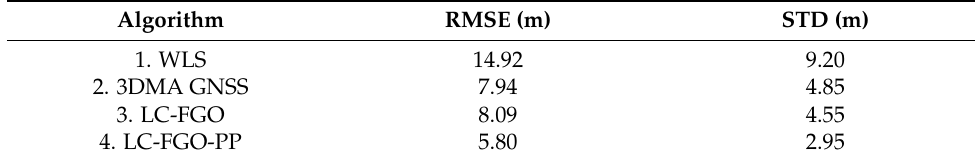
Table 2. Statistics of vehicle-mounted trip results.